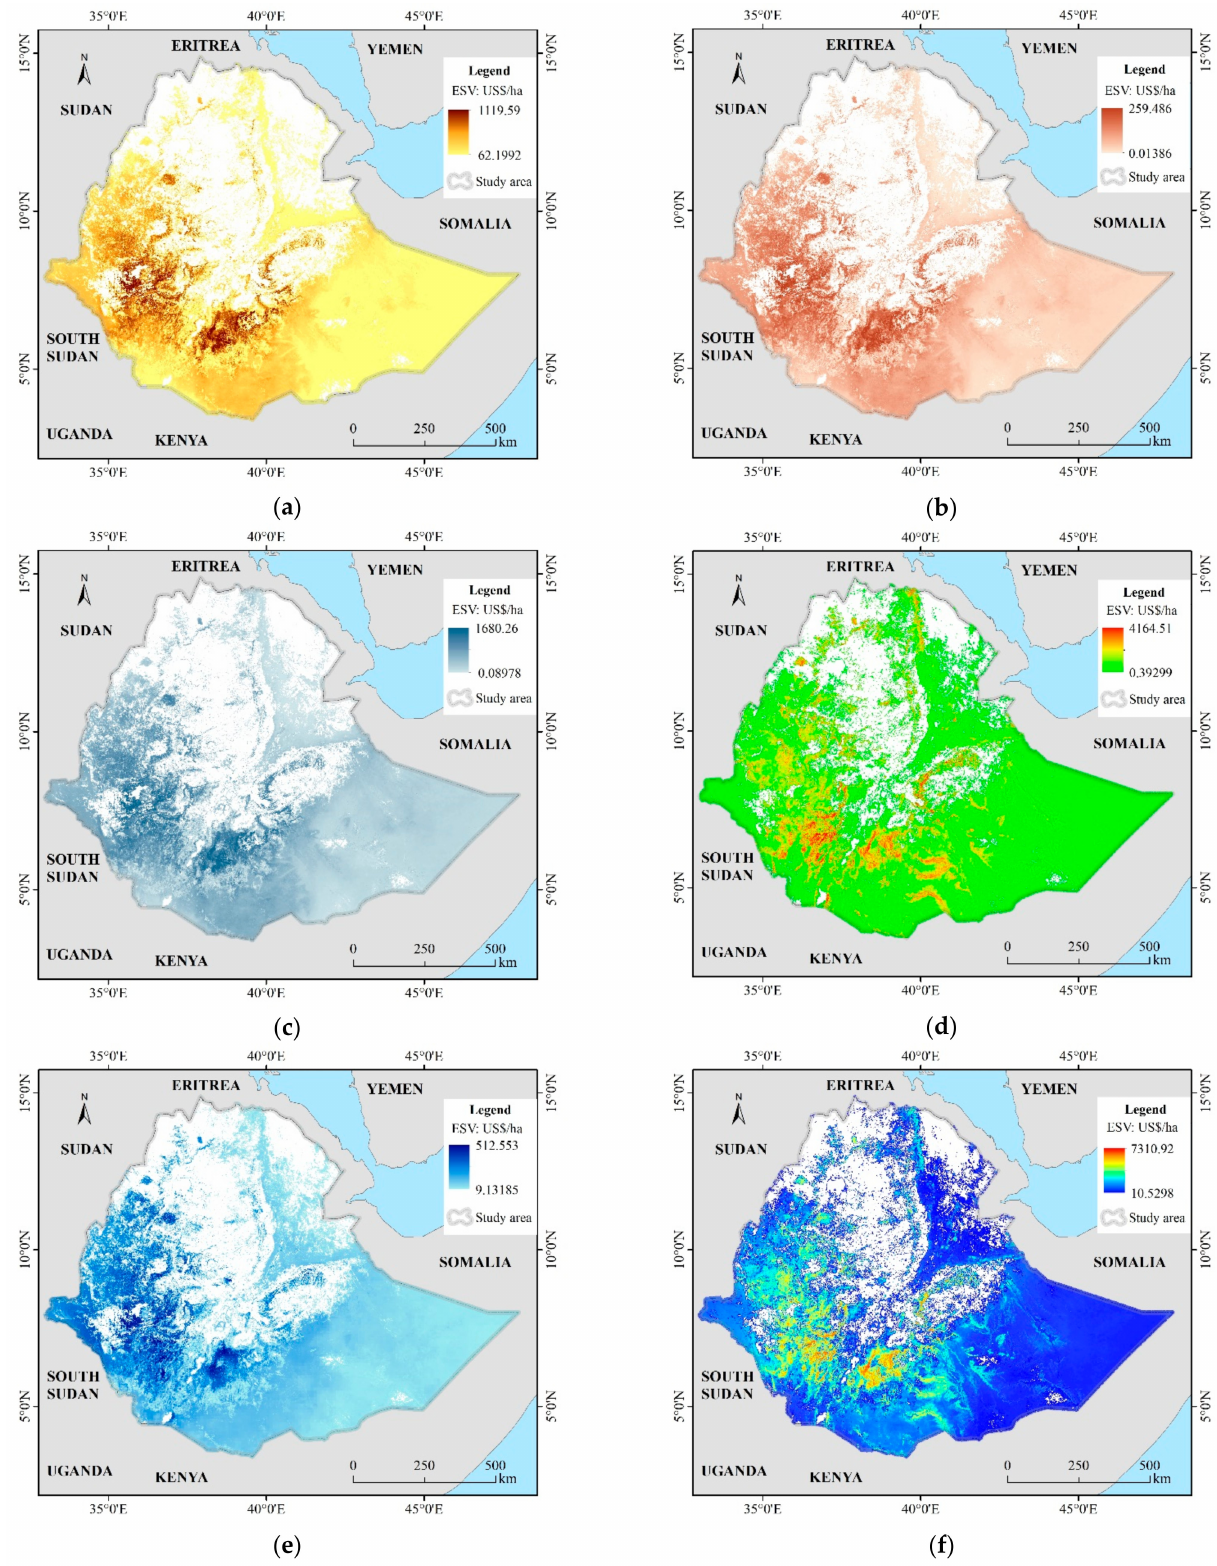
Figure 4. Different service values of grassland ecosystem in Ethiopia. ( a ) ESV1: organic matter production value; ( b ) ESV2: promoting nutrient circulation value; ( c ) ESV3: gas regulation value; ( d ) ESV4: soil conservation value; ( e ) ESV5: water conservation value; ( f ) Total